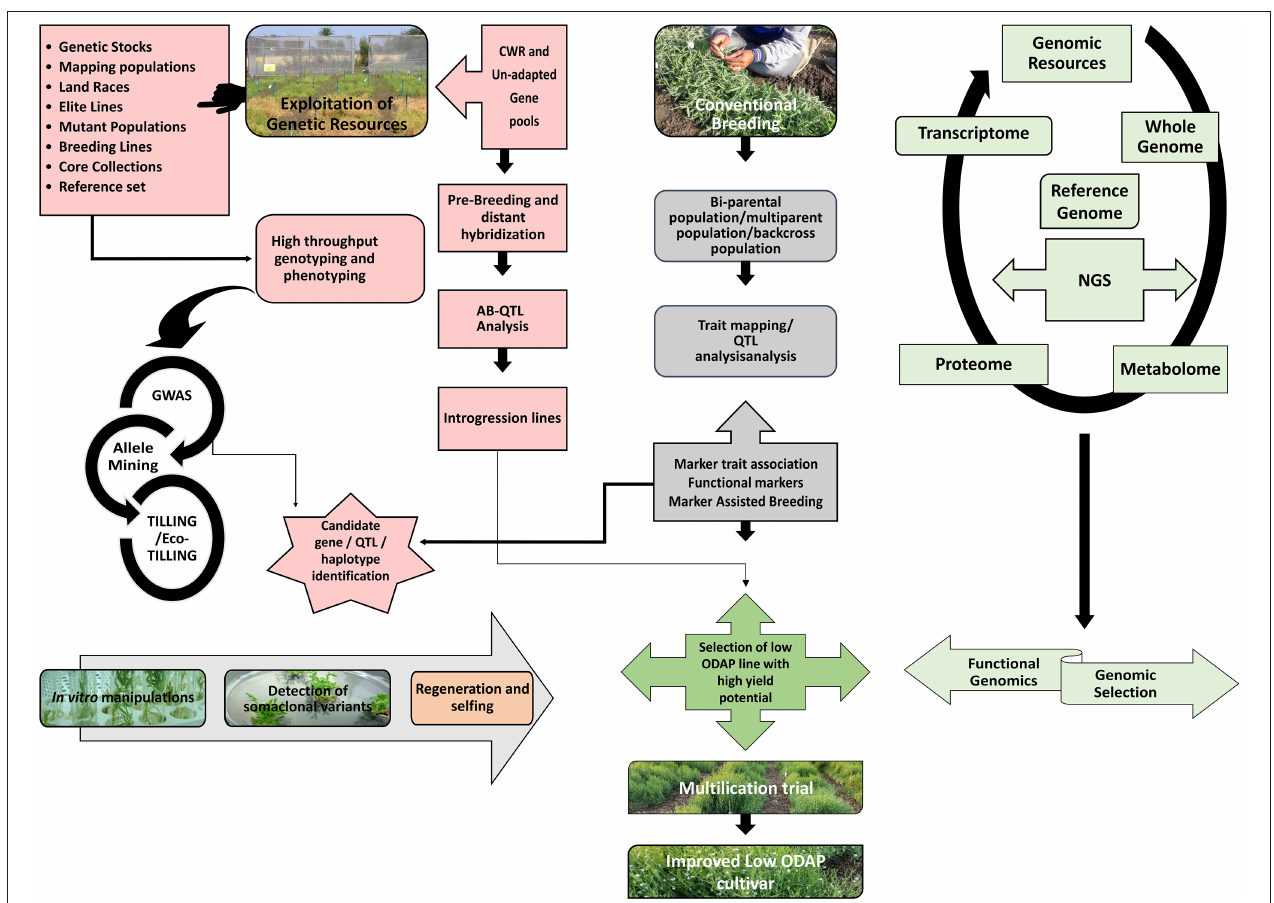
FIGURE 2 | Integrative breeding and genomic approaches for development of low-ODAP grass pea cultivars. The figure depicts that exploitation of genetic resources can be achieved either through utilizing members of GP-I as well as CWR or unadapted gene pools through opting pre-breeding and distant hybridization strategy which will further lead to the discovery of candidate genes/ haplotype or QTLs. Simultaneously, conventional breeding strategy can be opted for development of different kinds of mapping populations for establishing marker-trait associations. Genomic resources can be deployed via NGS approach. Functional genomics and Genomic selection can also be utilized for unraveling the genetic mechanism of key biosynthetic pathways as well as estimation of breeding values for selection of superior cultivars. Different in vitro strategies can also be successful for detection of low-ODAP somaclonal variants. All these approaches ultimately lead to the development of stable low-ODAP cultivars with good agronomic base. CWR, Crop Wild Relatives; AB-QTL, Advanced Backcross QTL; GWAS, Genome Wide Association Study; TILLING, Targeting Induced Local Lesions in Genomes; QTL, Quantitative Trait Loci; NGS, Next Generation